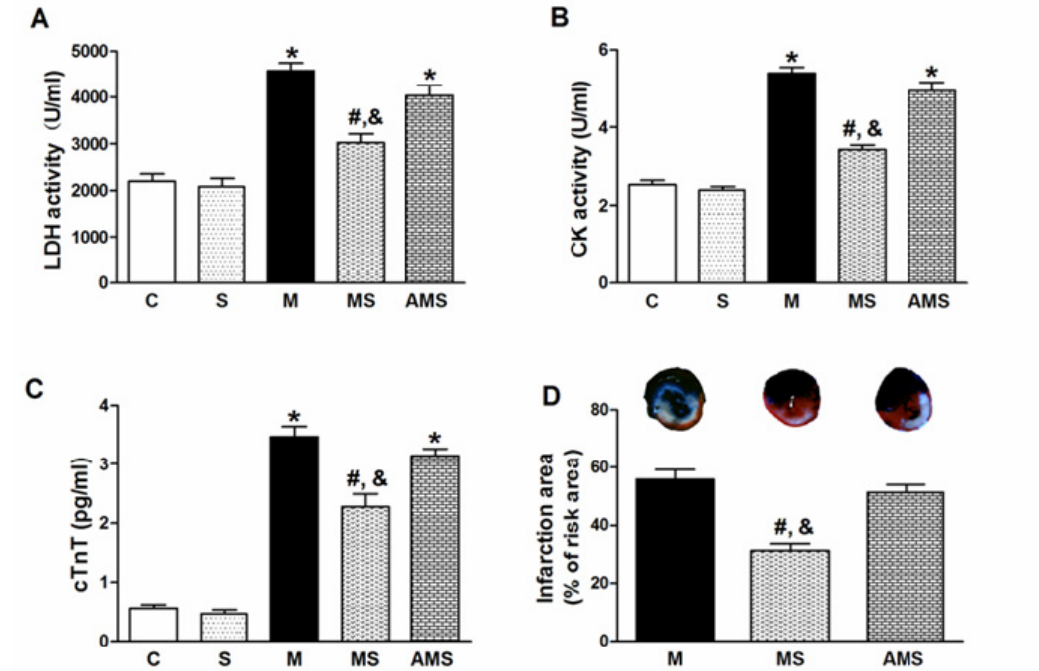
Figure 1. Vagal stimulation decreased susceptibility of myocardial injury. The animals were randomized into five groups: C indicates sham-operated rats with sham stimulation; S depicts rats treated with only right vagus nerve stimulation (VNS); M indicates acute myocardial infarction (AMI) rats treated without VNS; MS represents AMI rats treated with VNS while AMS means the acute myocardial infarction rats with both vagal stimulation and atropine sulfate. ( A ) Serum levels of LDH from each group; ( B ) Serum levels of creatine kinase (CK) from each group ( n = 12 for each group); ( C ) Serum levels of cTnT from each group; ( D ) Reduction in AMI-induced myocardial infarct size (percentage risk area) by VNS. Note: the blue color is Evans blue dye; the red color is 2,3,5-triphenyltetrazolium chloride staining corresponding to the uninfarcted area. The white color corresponds to the infarcted area. Data are the mean ± SEM ( n = 6). * p < 0.05 compared with control (C); # , & p < 0.05 compared with M and AMS,